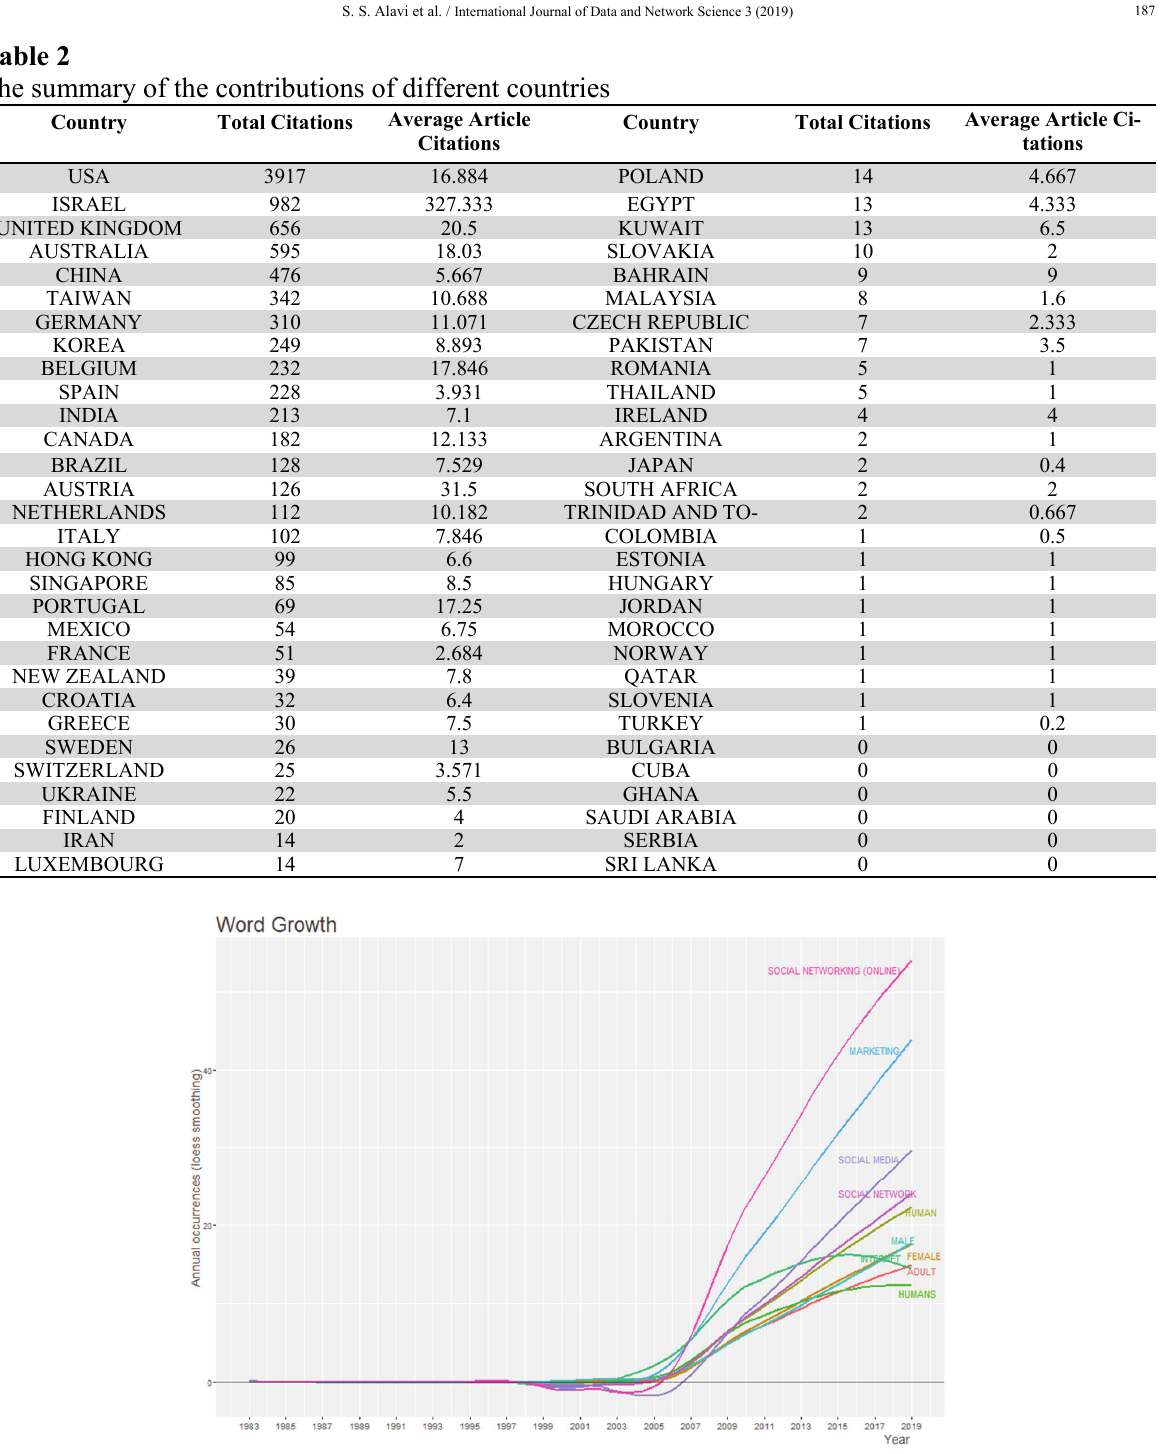
Fig. 1. The summary of the most popular keywords used in papers about advertising in social media According to Table 2, researchers from USA have published 3917 papers followed by Israel with 982 papers and United Kingdom with 656 papers. In terms of the average citation, papers published by re- searchers in Israel and United Kingdom have maintained the highest citations. Fig. 2 shows the results of the collaborations among various